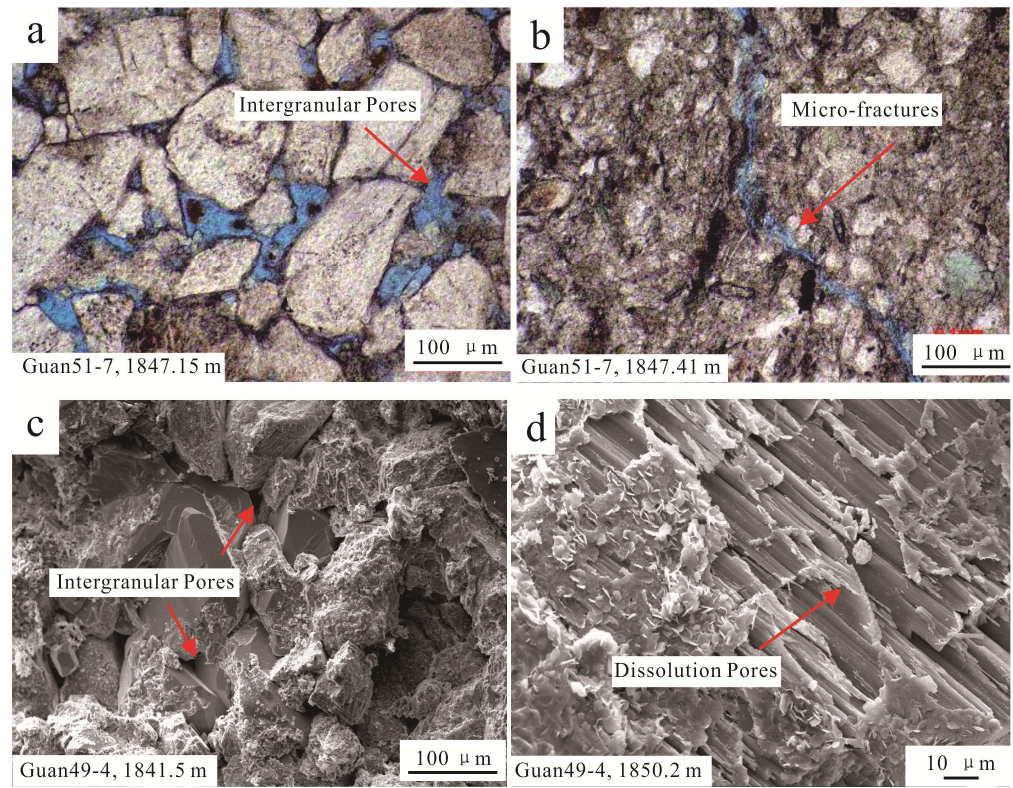
Figure 7. Typical pore types: ( a ) micrograph of casting sheet image showing intergranular pores; ( b ) micrograph of casting sheet image showing micro fractures; ( c ) micrograph of SEM showing intergranular pores; ( d ) micrograph of SEM showing dissolution pores.